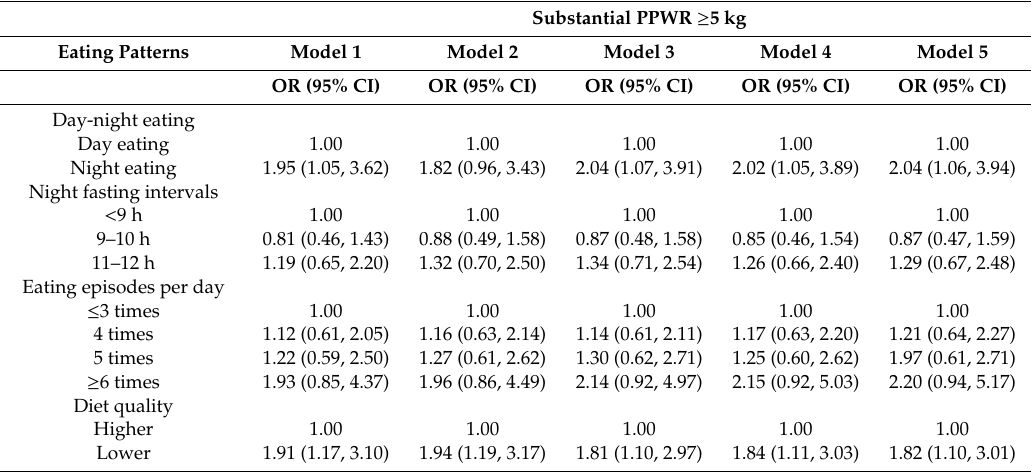
Table 3. Maternal eating patterns during pregnancy and substantial postpartum weight retention ( ≥ 5 kg) at 18 months ( n =